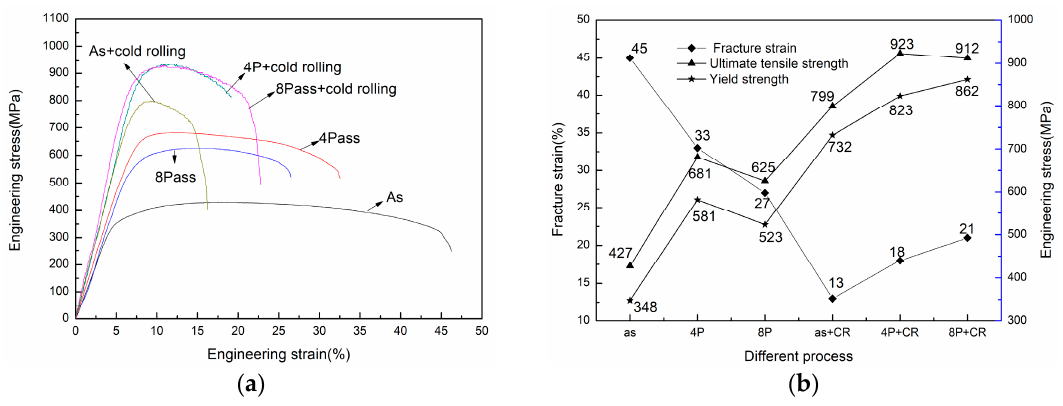
Figure 7. Mechanical properties of CP-Ti: ( a ) tensile curves of CP-Ti at different processing stages; ( b ) variation of ultimate tensile strength, tensile yield strength and fracture strain with different processing stages.